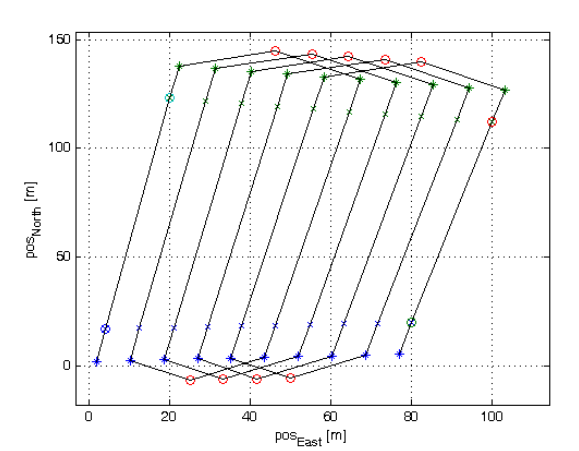
Figure 4: Initial mission planning with automatically defining GPS waypoints in order to receive a predefined distance of the flight lines above the complete flight area. The final GPS way- point in this example can be seen in the picture in the lower right corner.